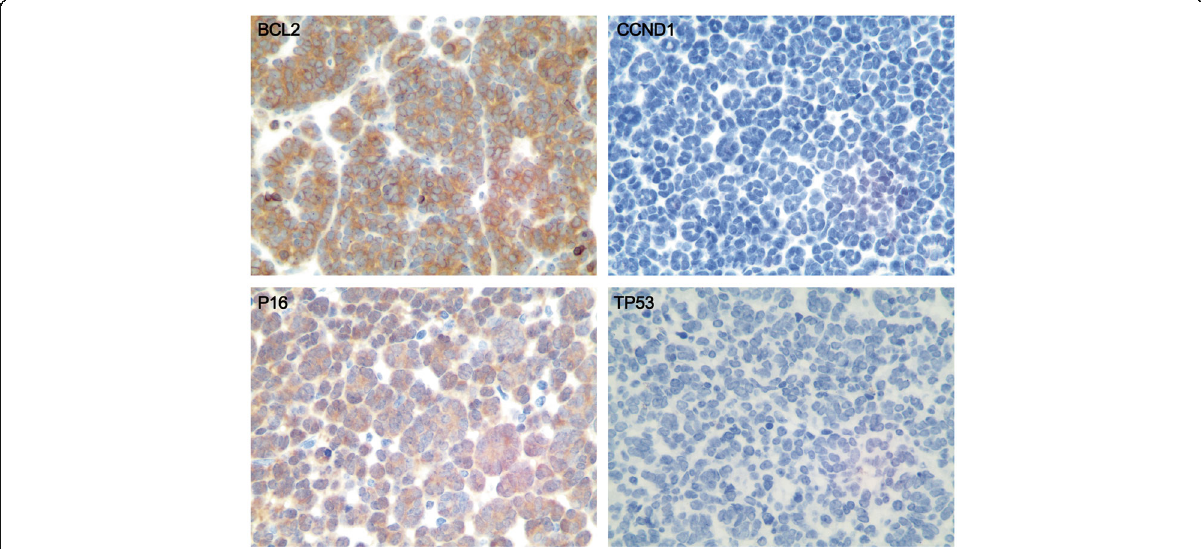
Fig. 4 Immunohistochemical staining for BCL2, CCND1, P16 and TP53 in representative MA tissues, 400×. The staining of positive tumor cells ranged from 1+ to 3+, indicating diffuse, moderate, and strong cytoplasmic expression